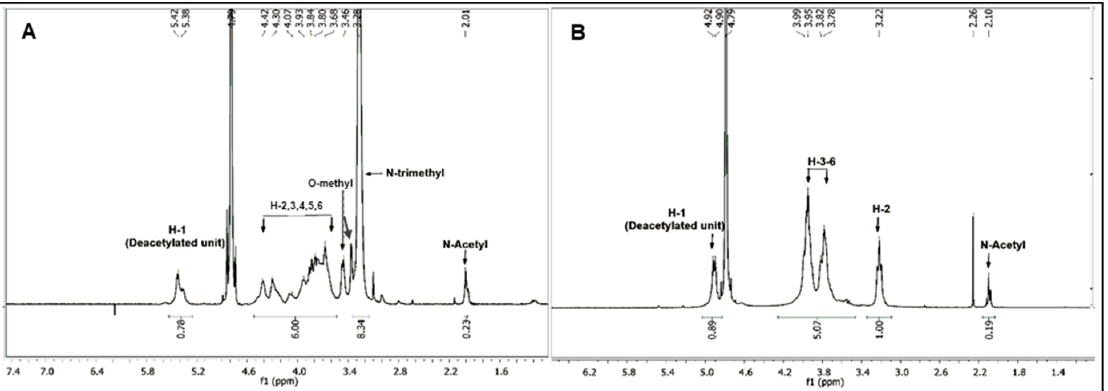
Figure 1. 1 H-NMR spectrum of the highly quaternized N , N , N -trimethyl chitosan (TMC) ( A ) which